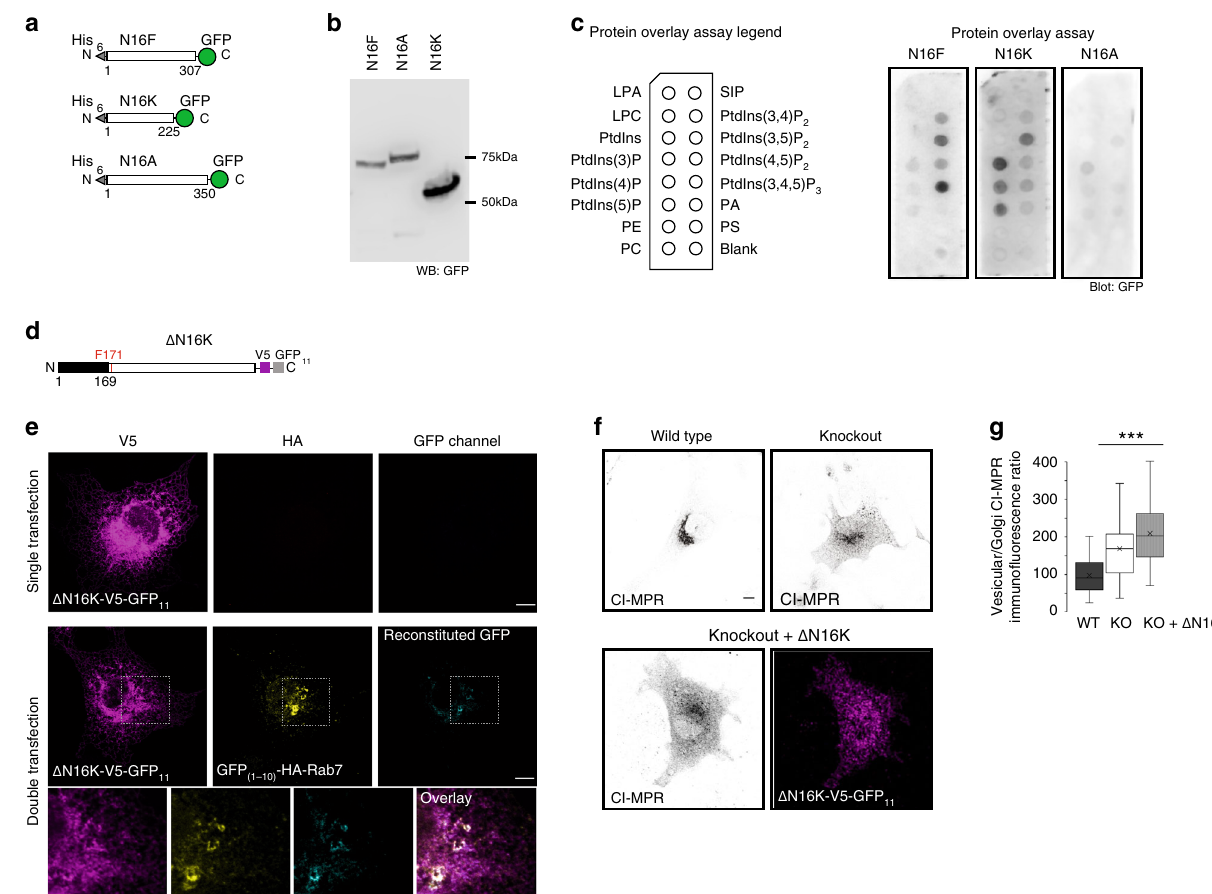
Fig. 6 TMEM16K N-terminal domain. a Scheme of puri fi cation constructs of N-terminal cytosolic domains of TMEM16F (N16F, predicted MW 63.6 kDa), TMEM16K (N16K, predicted MW 53.4 kDa) and TMEM16A (N16A, predicted MW 67.5 kDa) b Western blot of puri fi ed N-terminal cytosolic domains revealed with anti-GFP antibody and horseradish peroxidase. c Lipid binding of predicted phosphatidylinositol binding domains was evaluated by loading 10 µ g of puri fi ed proteins to the PIP-strips and visualized with blotting with anti-GFP antibody and horseradish peroxidase. Representative images of three independent blots. d Scheme of N-terminal truncation mutant of TMEM16K where 1 – 169 amino acids were deleted. e Split-GFP reconstitution assay to evaluate N-terminal truncation mutant for its ability to reconstitute GFP with Rab7. Cell were single or double transfected cells with Δ N – terminal TMEM16K-V5-GFP 11 and GFP (1 – 10) tagged Rab7, Scale bar 10 µ m for rows 1, 2, and 5 µ m for inset in the row 3. f Representative images of the ability of Δ N16K-V5-GFP fi cking defect when introduced in TMEM16K KO cells as measured by CI-MPR assay described in 11 to rescue endosomal retrograde traf Fig. 3a (WT and KO from Fig. 3a repeated for clarity of comparison) Scale bar 10 µ m. g Quanti fi cation (same data from Fig. 3a added to this graph for clarity of comparison). Single factor ANOVA, p value = 2.03E − 49 with post-test Bonferroni-corrected two sided t -test with pairwise comparison with WT (three biological replicates, n = 168 WT, 181 TMEM16K KO, p value = 1.37E − 26*** and 161 TMEM16K KO + Δ N16K-V5-GFP 11 cells, p value = 6.06E − 47***). In the box and whiskers plot, the box includes the fi rst quartile and the third quartile, with the central line representing the median. Whiskers represent the minimum and maximum values of data. X inside the box represents the mean of data. Source data are provided as a Source Data fi